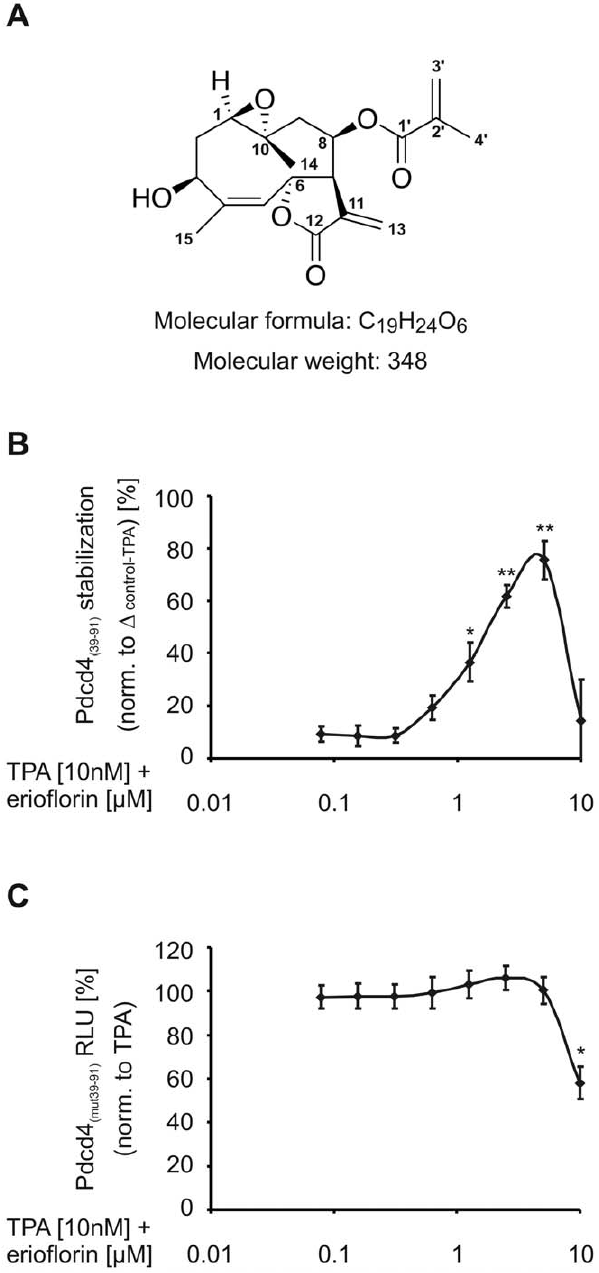
Figure 1. Erioflorin stabilizes Pdcd4 (39–91) luc from TPA-induced degradation. (A) Structure of erioflorin (Mwt=348.4). (B) Stably Pdcd4 (39–91) luc expressing HEK293 cells were treated for 8 h with TPA (10 nM) with increasing concentrations of erioflorin (0.0625–10 m M). Pdcd4 stabilizing activity was determined relative to D (RLU control – RLU TPA-only ). (C) Stably Pdcd4 (mut39–91) luc expressing HEK293 cells were treated as in (B). Luciferase activity is given relative to TPA-treated controls. All data are presented as means 6 SEM (n $ 3, *p , 0.05, **p ,